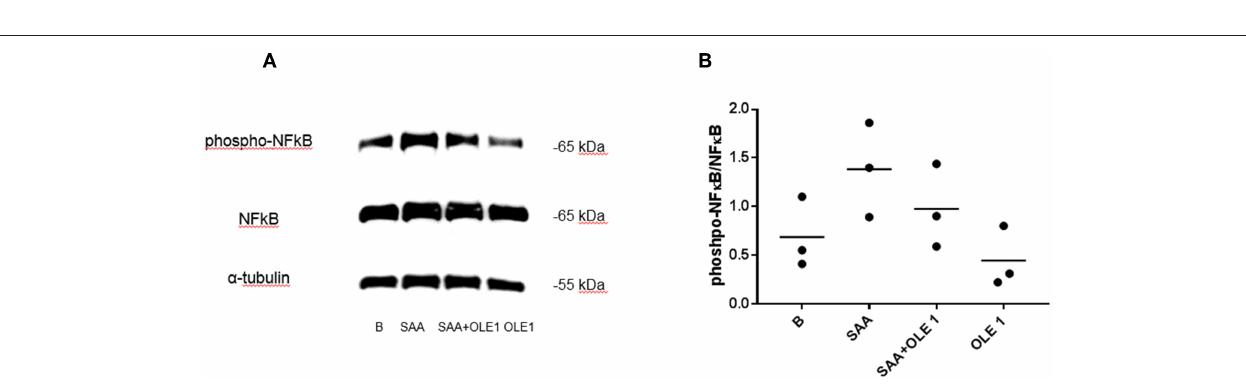
FIGURE 2 | OLE decreases mRNA expression of adhesion molecules and MMP2 in HCAEC. The expression of VCAM-1 (A) , E-selectin (B) , MMP2 (C) , and MMP9 (D) mRNA was determined by qPCR. Mean of 3 biological replicates is shown. HCAEC were treated with OLE (0.5 mg/ml, 1 mg/ml) 45min prior to SAA addition (1,000nM, 24h). Data was analyzed using RM one way ANOVA test with Tukey’s multiple comparison test * p > 0.05 ** p > 0.01; **** P < 0.0001.